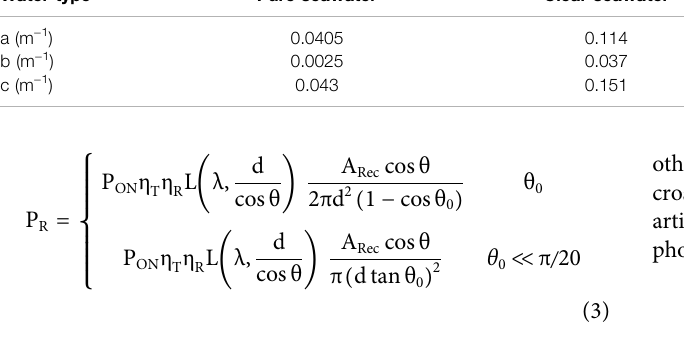
TABLE 2 | Absorption, scattering, and extinction coef fi cient for the Pure seawater and three Petzold water types. Water